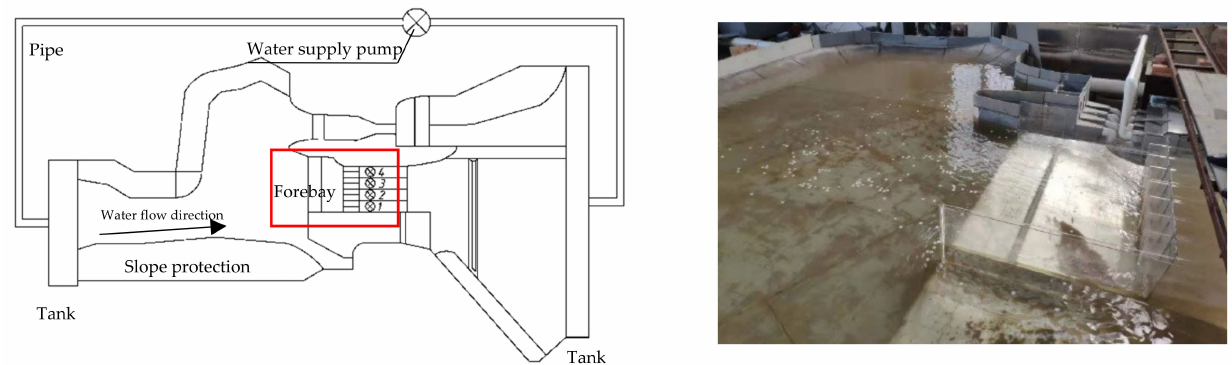
Figure 3. General layout of the test and the local model diagram of the